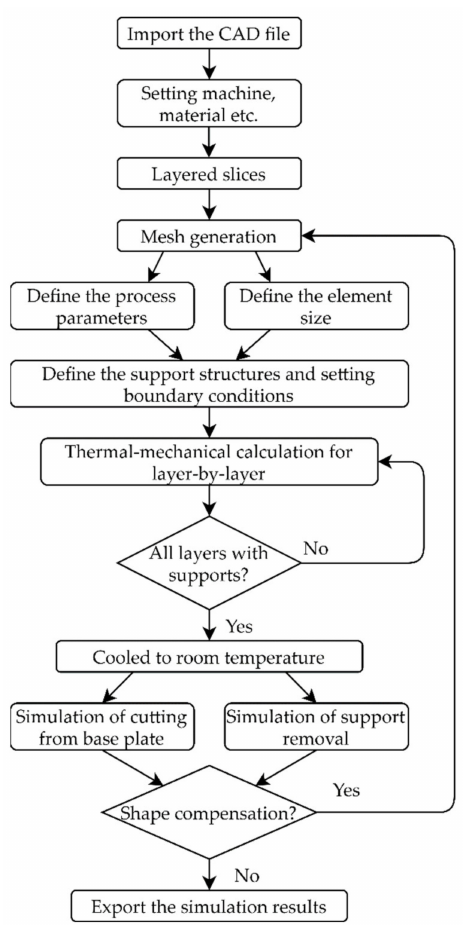
Figure 1. Flowchart of the simulation